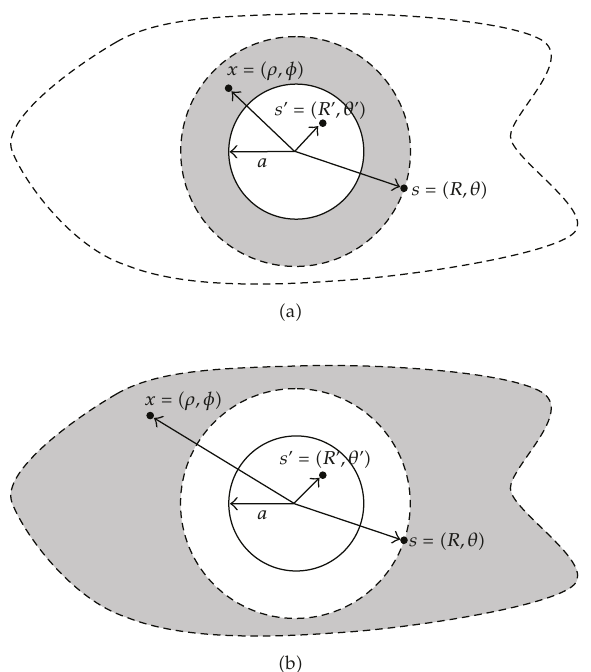
Figure 6: Green’s function of (cid:5) a (cid:6) the inner domain (cid:5) a < ρ < R (cid:6) and (cid:5) b (cid:6) the outer domain (cid:5) R < ρ < ∞ (cid:6) for the exterior